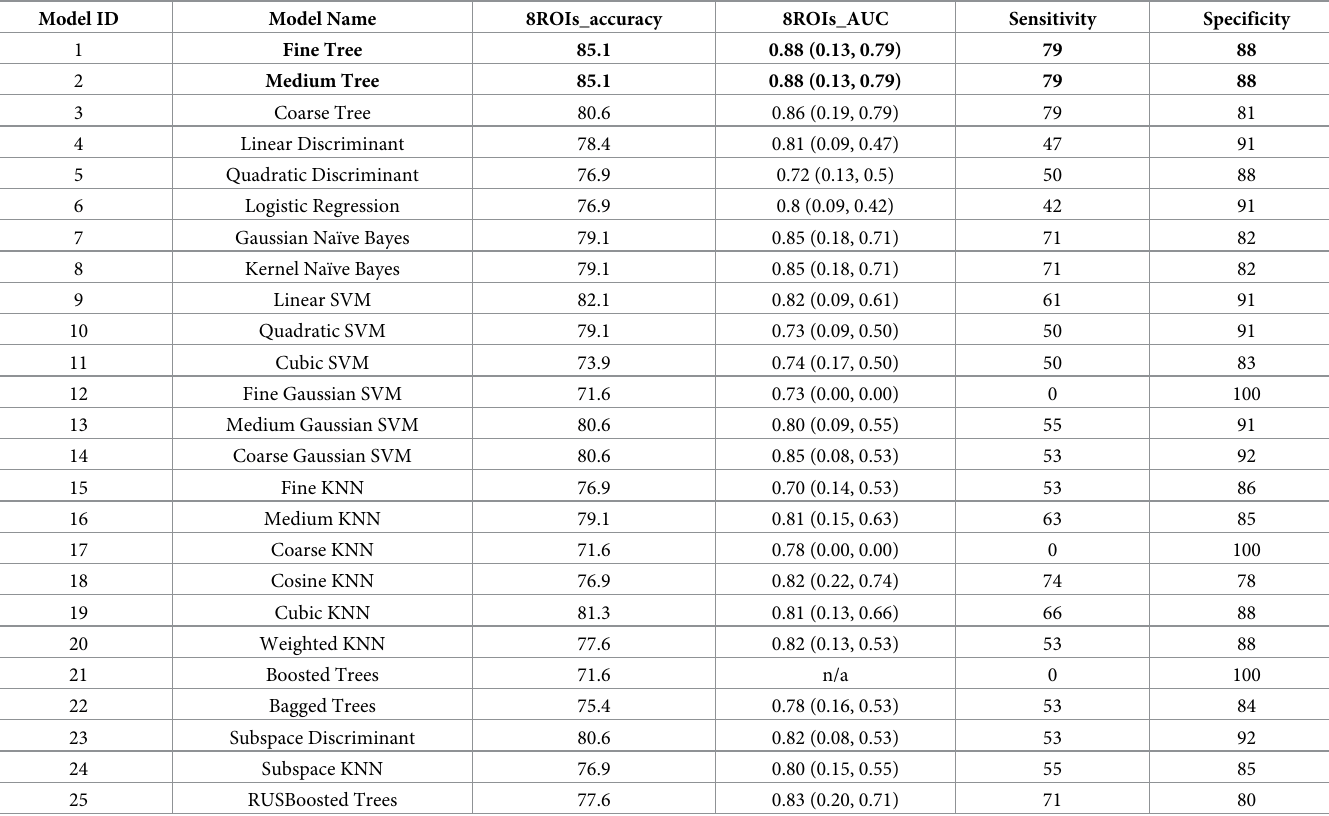
Table 3. Performance of 25 classification algorithms.